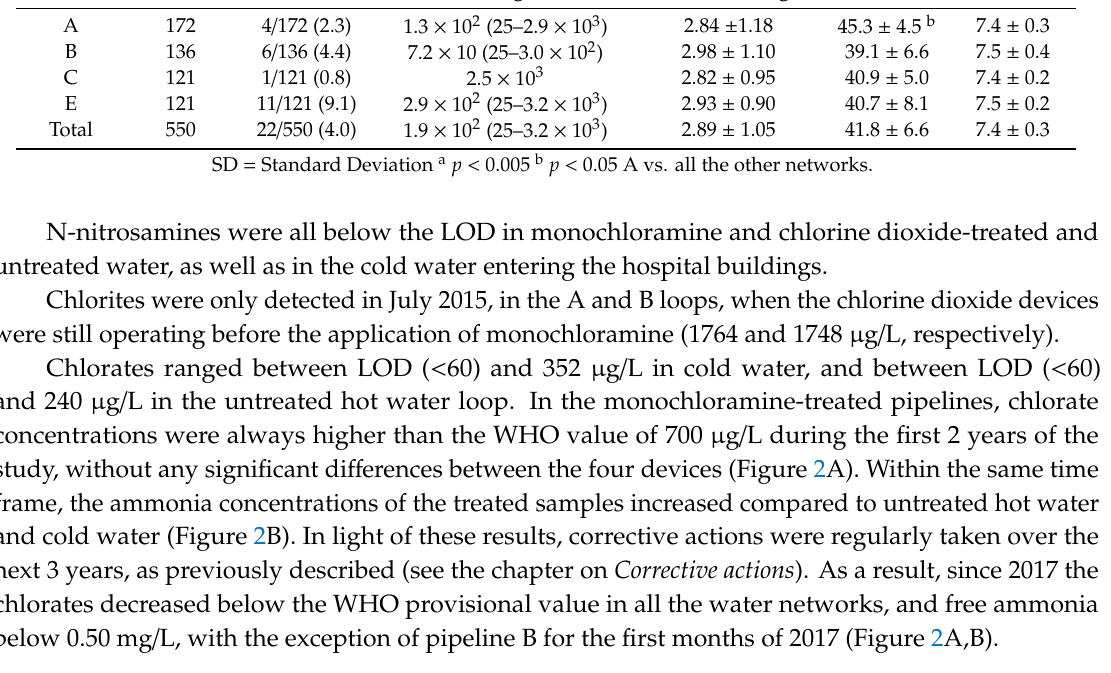
Table 1. Microbiological and physical–chemical parameters in water samples collected from the four monochloramine ‐ treated